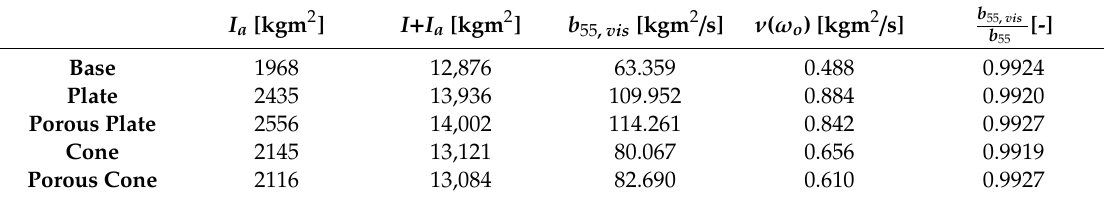
Table 3. Added mass moment of inertia, total mass moment of inertia, coefficients of viscous and radiation damping, and ratio of viscous damping to total damping for a pitch motion at natural frequencies of the models from the potential-based motion analysis.